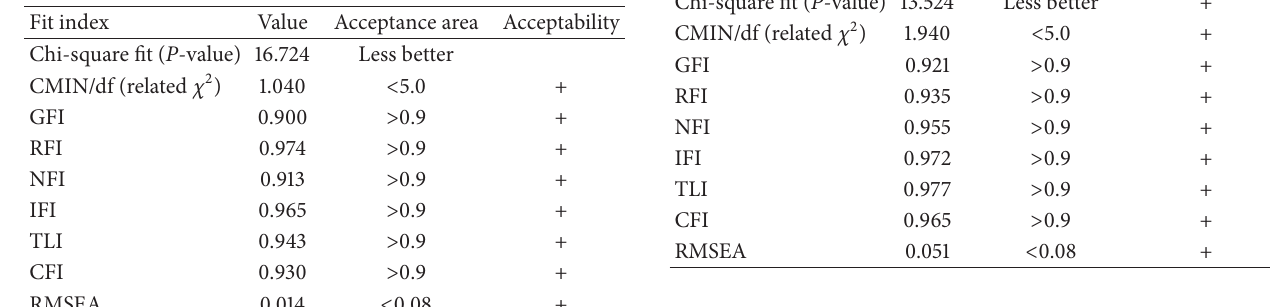
Table 2: Factor loading for modified model of socioeconomic status.